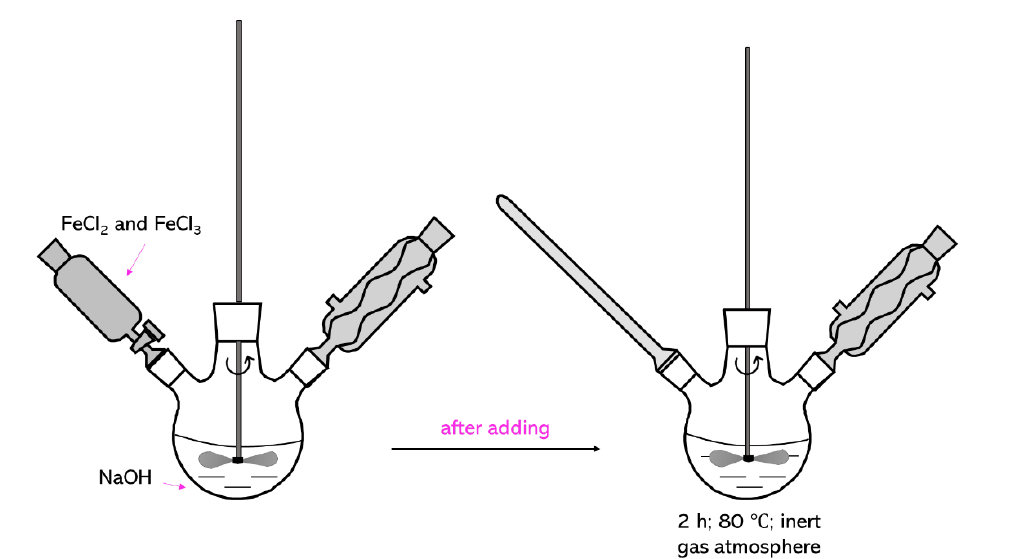
Figure 14. The scheme of Massart synthesis.